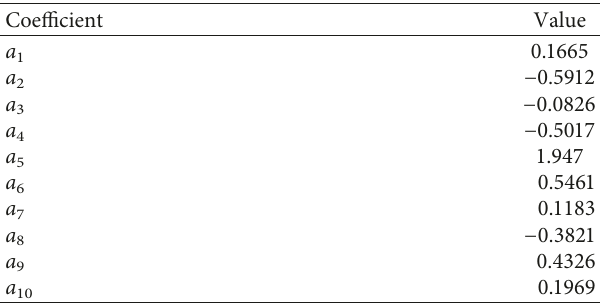
Figure 7: Data fitting of A , B , and C. (a) The coefficient A . (b) The coefficient B . (c) The coefficient C . Table 1: The coefficients in equation